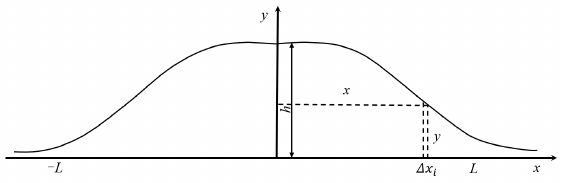
Figure 3. Sediment diffusion slope curve with unrestricted slurry.